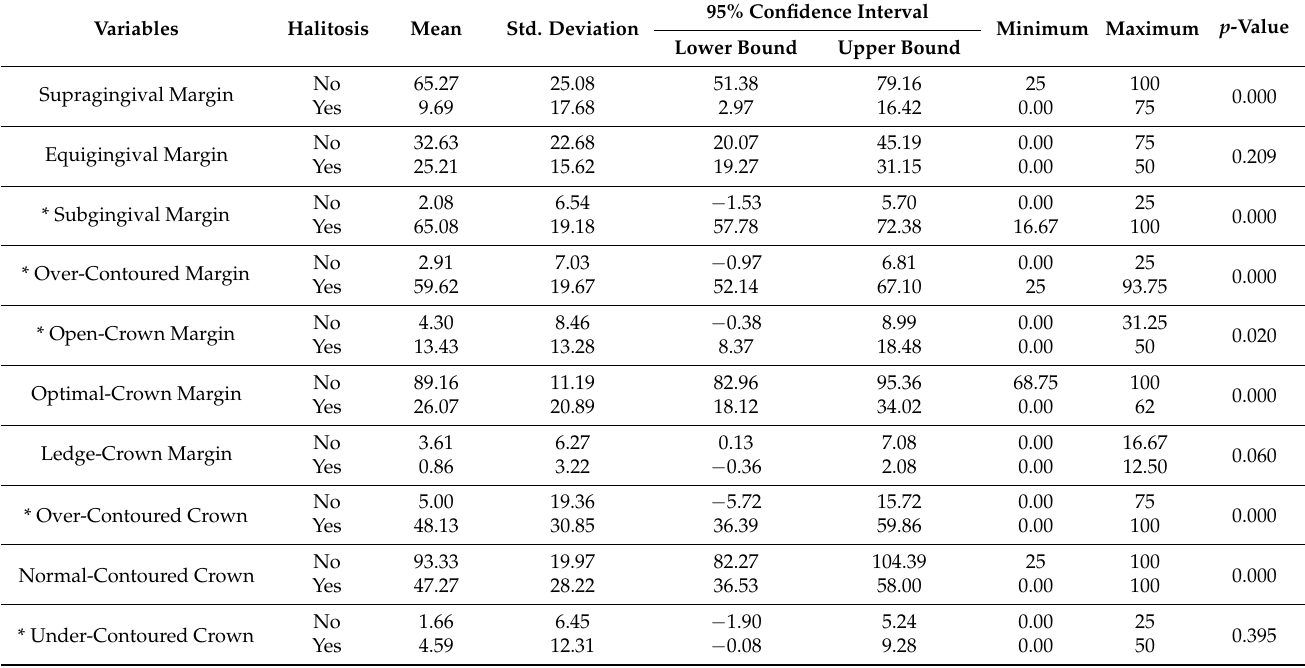
Table 4. Comparison of different crown parameters in relation to presence/absence of halitosis ( n = 44).